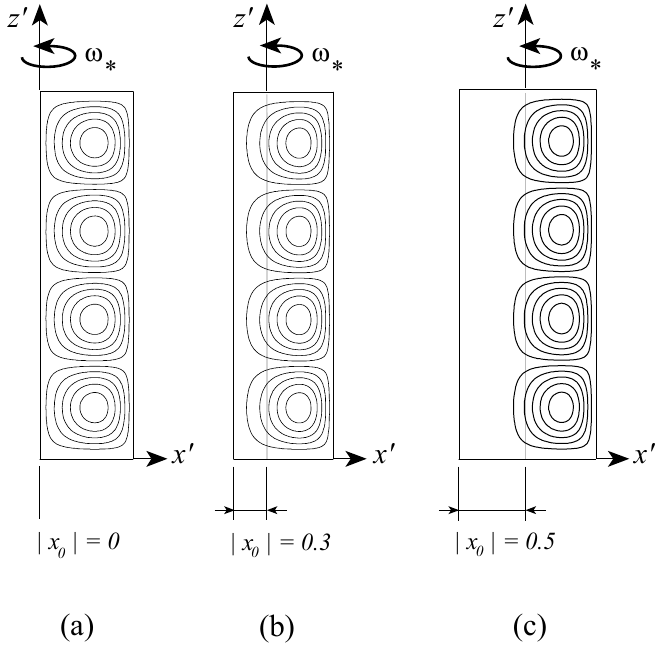
Figure 9. The convective flow field at marginal stability for three di ff erent values of | x 0 | ; 10 streamlines equally divided between ψ min and ψ max . ( a ) streamlines for a layer adjacent to the rotation axis | x 0 | = 0; ( b ) streamlines for the axis of rotation located at | x 0 | = 0.3; ( c ) streamlines for the axis of rotation located at | x 0 | = 0.5; (Reprinted from [41], with permission from Elsevier Science Ltd.)